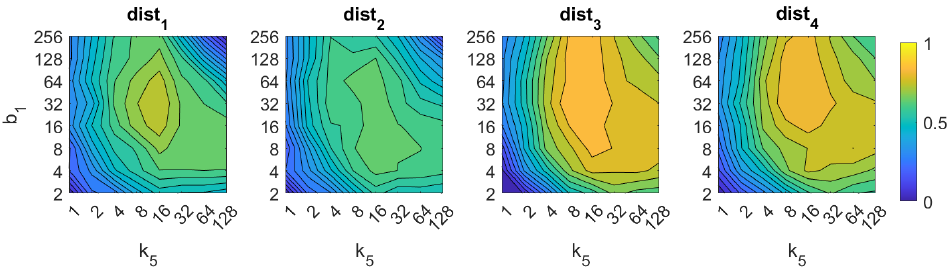
Figure 7. HOG image retrieval problem. Success rate of the method. k 5 is the number of horizontal cells and b 1 the number of bins per histogram (Table